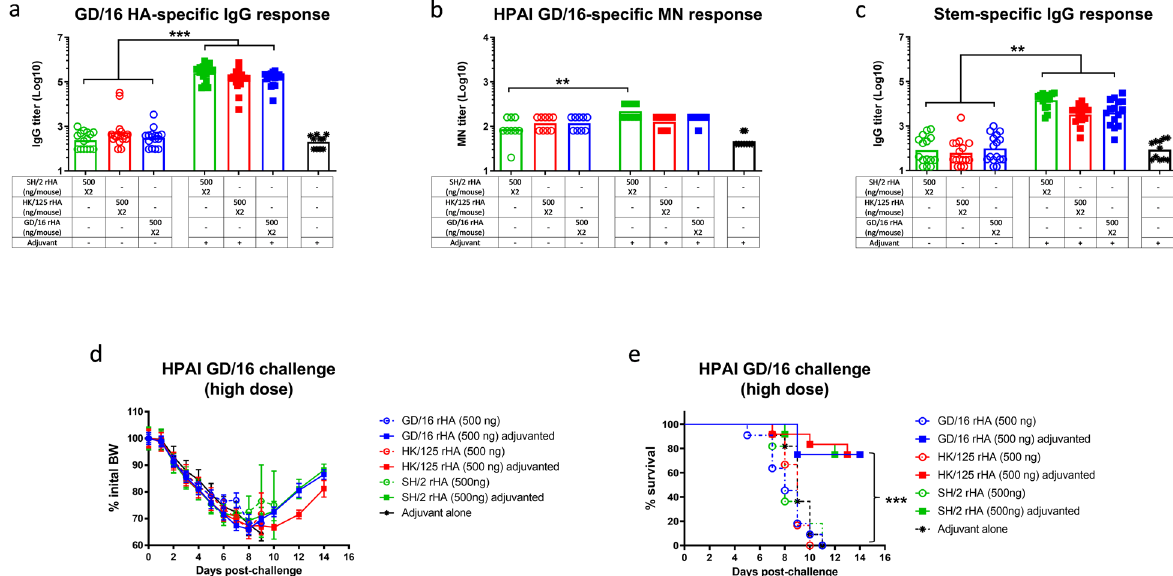
Fig. 6 Immunogenicity and protection of recombinant HA against highly pathogenic avian in fl uenza H7N9 challenge. BALB/c mice were immunized with recombinant HA (rHA) of H7N9 A/Shanghai/2/2013 (SH/2), A/Hong Kong/125/2017 (HK/125), or A/Guangdong/17SF003/2016 (GD/16) with or without adjuvant. Immunized mice were challenged with highly pathogenic avian in fl uenza (HPAI) wild type (wt) GD/16 virus at 5 × 10 7 TCID 50 /50 µl/mouse (high dose) in a BSL-3 + biocontainment. ( a ) IgG ELISA titers against GD/16 HA; ( b ) microneutralization (MN) titers against HPAI wt GD/16 virus; ( c ) HA group 2 stem-speci fi c Ig titers; ( d ) Body Weight (BW) and ( e ) survival after HPAI wt GD/16 challenge. Individual titers with geometric mean (bars) are shown ( n = 5 – 16 mice/group). ** p < 0.01 and *** p < 0.001 by Kruskal – Wallis test with Dunn ’ s multiple comparisons after log transformation (antibody responses) or by Log-rank (Mantel – Cox) test (survival